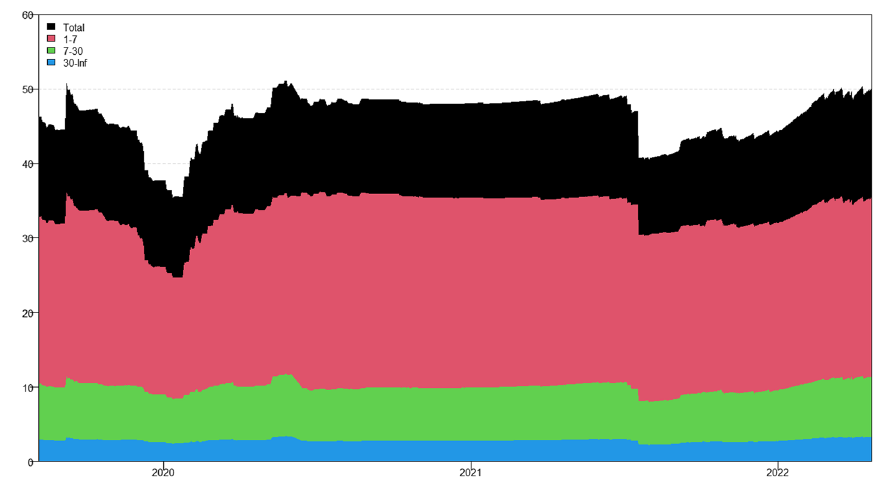
Fig. 25 Dynamic total connectedness—realized hyperkurtosis